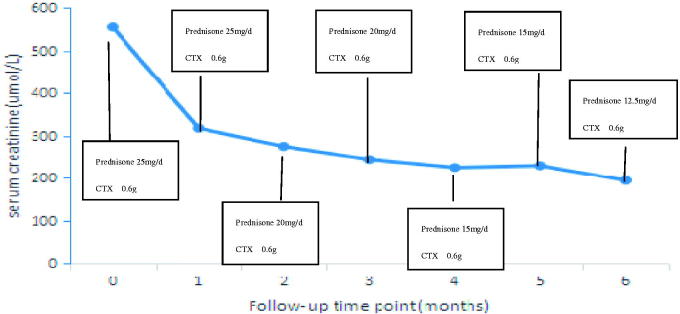
Changes in renal function during the follow-up, as indicated by the serum creatinine level.